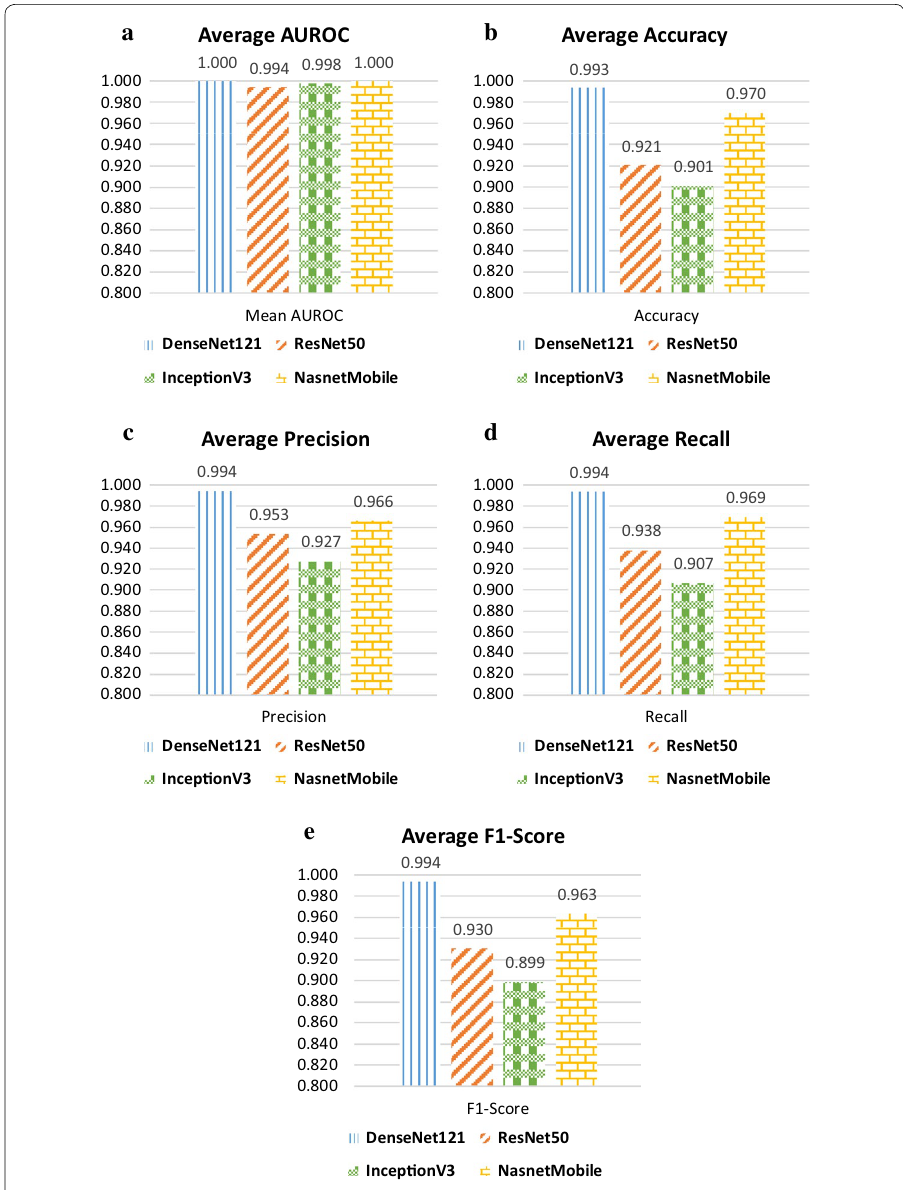
Fig. 8 Average testing performance a AUROC, b accuracy, c precision, d recall, e F1